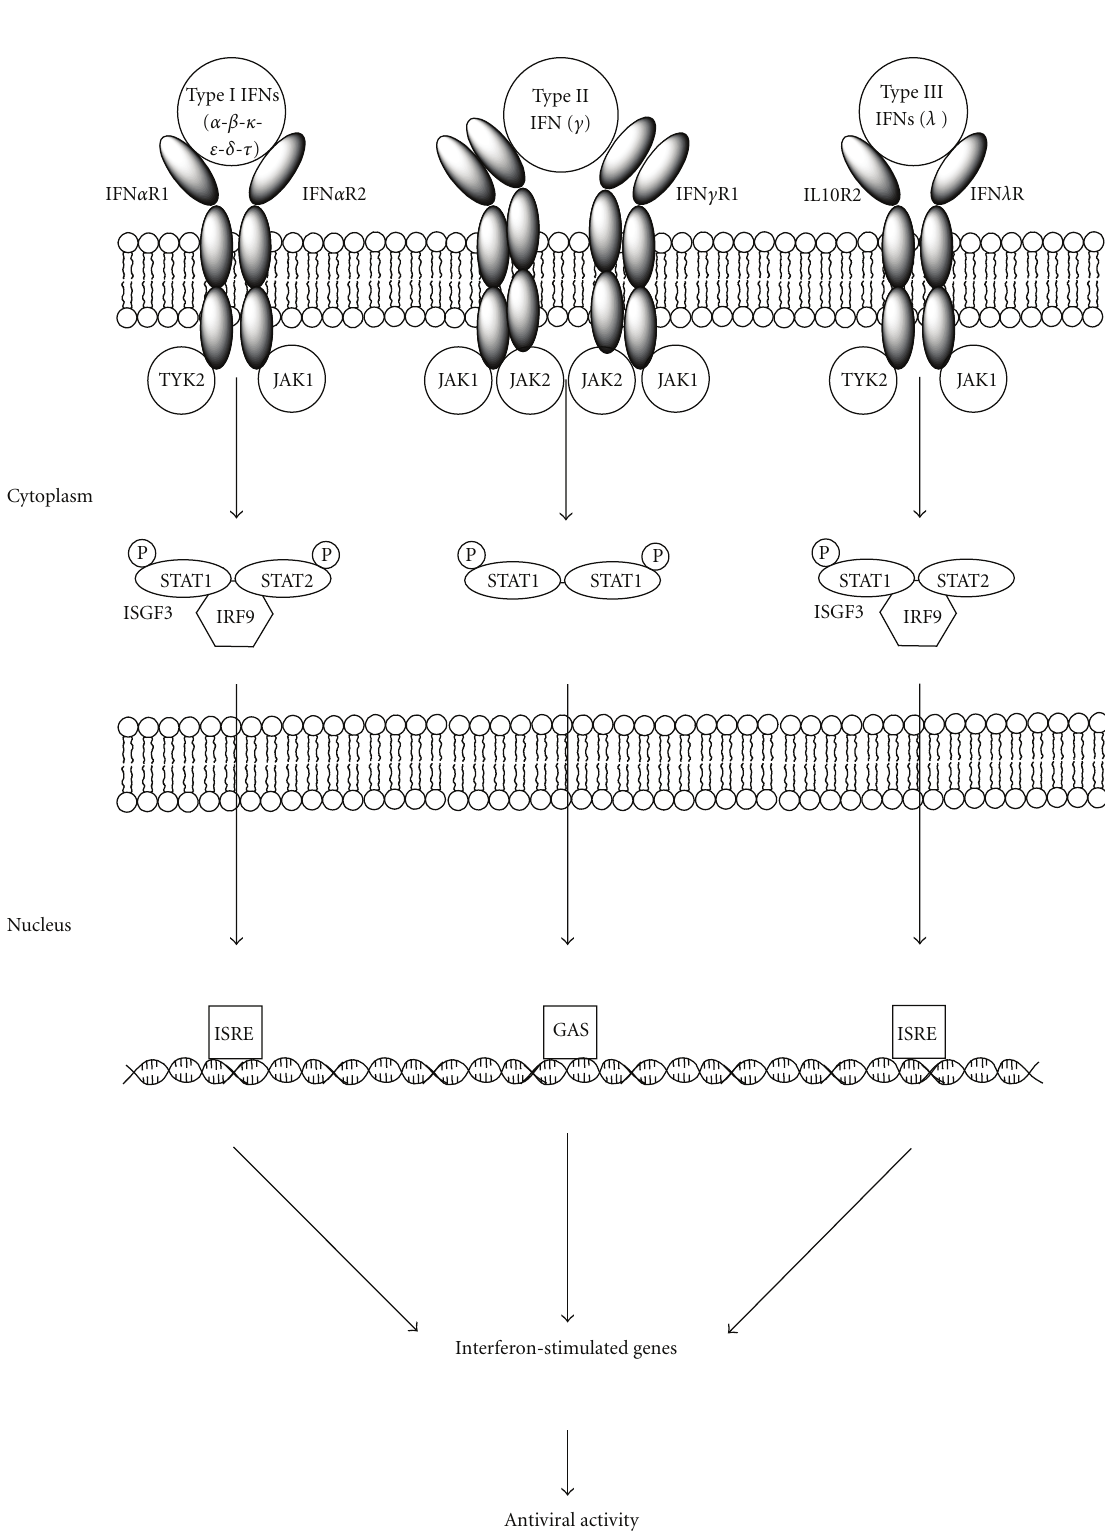
Figure 1: Types I, II, and III IFN receptors and their downstream signalling